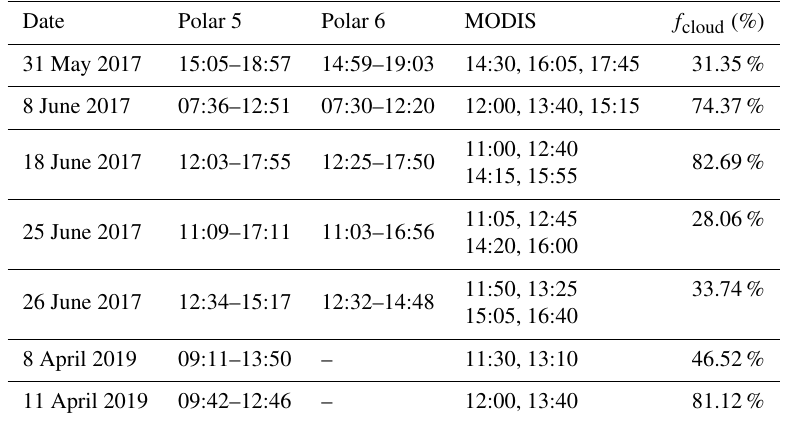
Table 5. Time stamps for airborne observations, satellite overflights in UTC, and cloud pixel percentages in the latitude–longitude ranges of aircraft during the ACLOUD and AFLUX campaigns (77.8–82.4 ◦ N, and − 0.25–20.5 ◦ E). Note that days with only broken-cloud observa- tions (cloud coverage greater than 90%) are not included in the